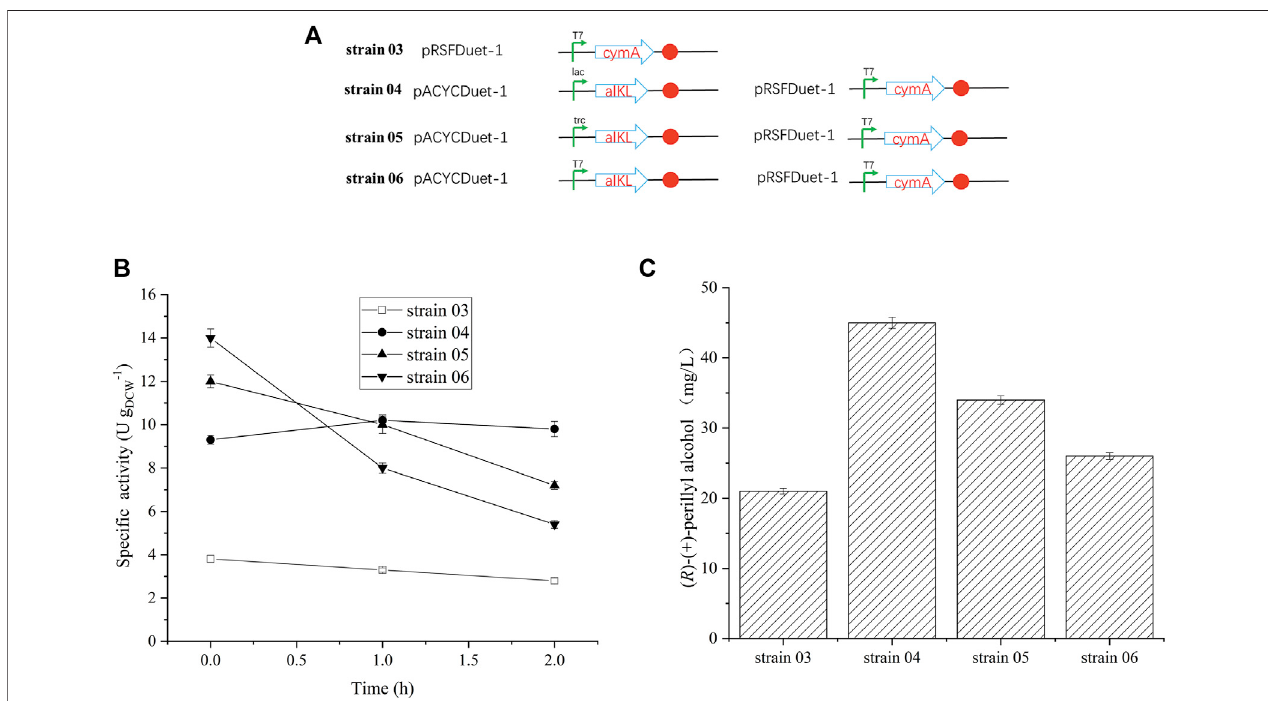
FIGURE 2 | Effect of alkL protein expression on ( R )-(+)-perillyl alcohol production. (A) Strains constructed by different promotors. (B) Whole-cell activity assays relatedtoalkLexpression. (C) Comparisonof( R )-(+)-perillylalcoholproductionineachstrain.Reactionconditions(20 ml):wholecellcatalysts(OD 600 =30),25 μ l( R )-(+)- limonene, 8.0 ml dioctyl phthalate (DINP), and PBS buffer (50 mM, pH 7.4) at 30 ° C for 6 h. Data expressed as mean ± s.d. ( n = 3).